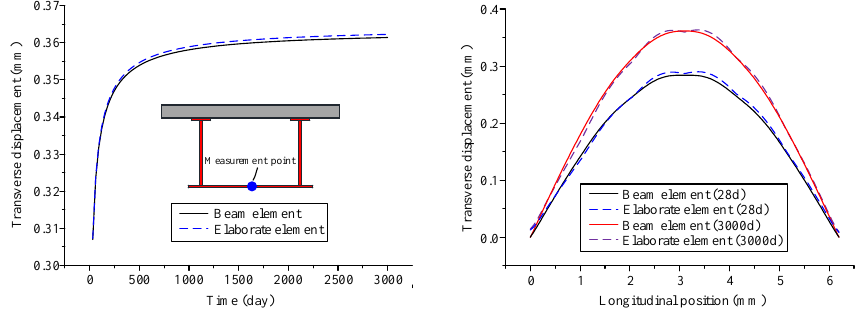
Figure 5. Transverse displacement variation in the curved composite box girder, with respect to time: ( a ) variation of transverse mid-span displacement with respect to time, ( b ) distribution of transverse displacement along the span.